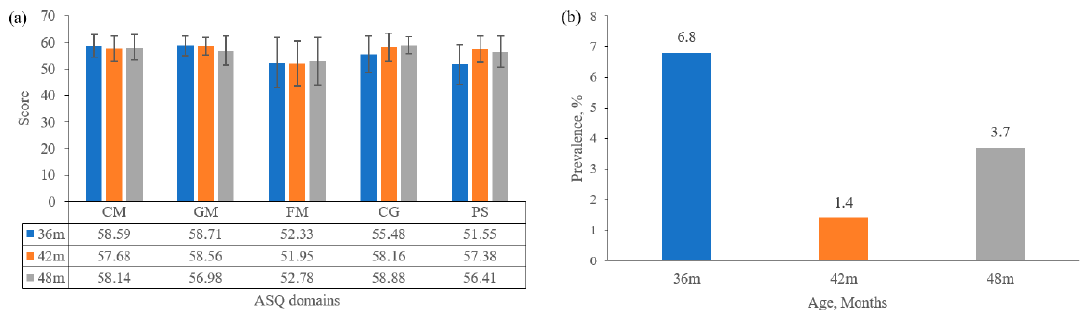
Figure 2. Children development outcome at 36 months, 42 months, 48 months. ( a ) ASQ-3 scores in different domains of children; ( b ) suspected developmental delay at 36 months, 42 months, 48 months.